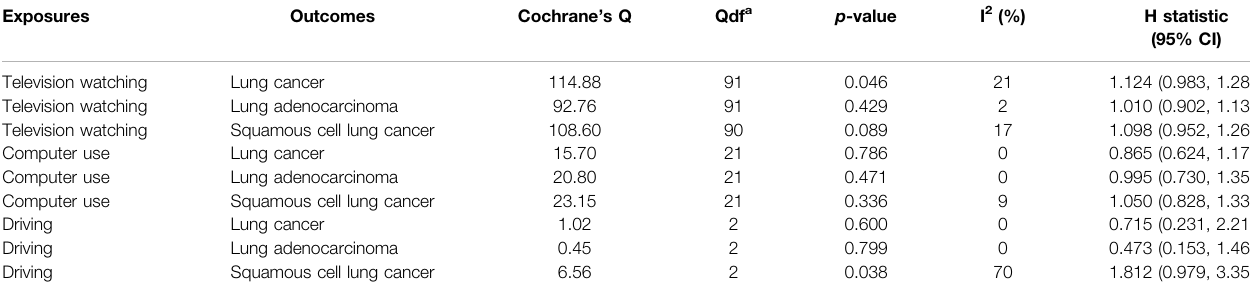
TABLE 3 | Heterogeneity test of the Mendelian randomization analyses between leisure sedentary behavior and risk of lung cancer. Exposures